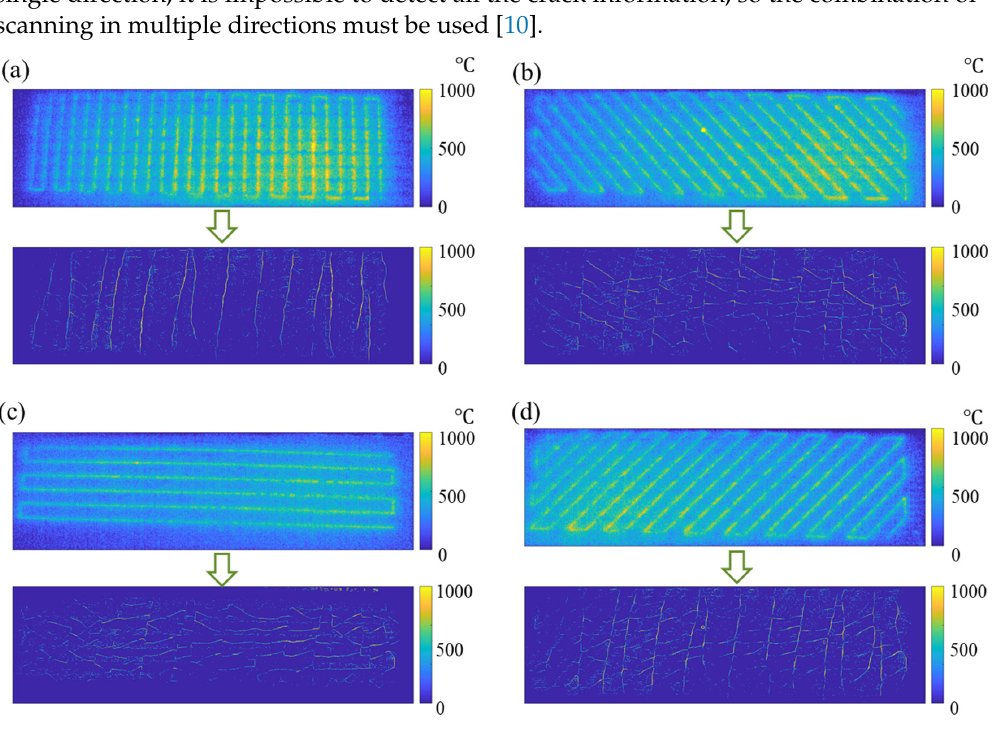
Figure 14. Temperature field of laser scanning in four directions and extraction results of crack mor ‐ ◦ direction; ( b ) 45 ◦ direction; ( c ) 90 ◦ direction; ( d ) 135 ◦ phology: ( a ) 0° direction; ( b ) 45° direction; ( c ) 90° direction; ( d ) 135° direction. morphology: ( a ) 0